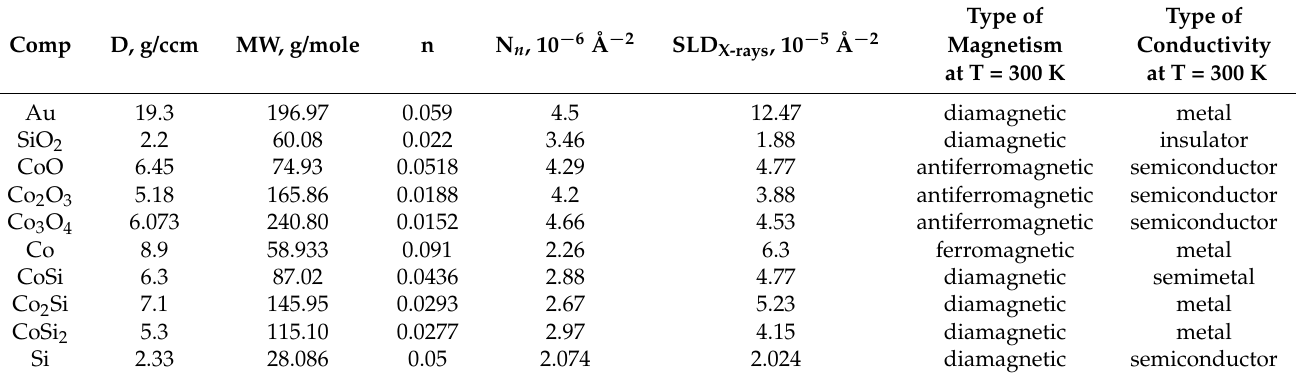
Table 5. The calculated N n and SLD X-rays values are given with Density (D), Molecular weight (MW) and Number of molecules per Å 3 (n) for compounds (Comp) that may be formed in the granular film, or at the